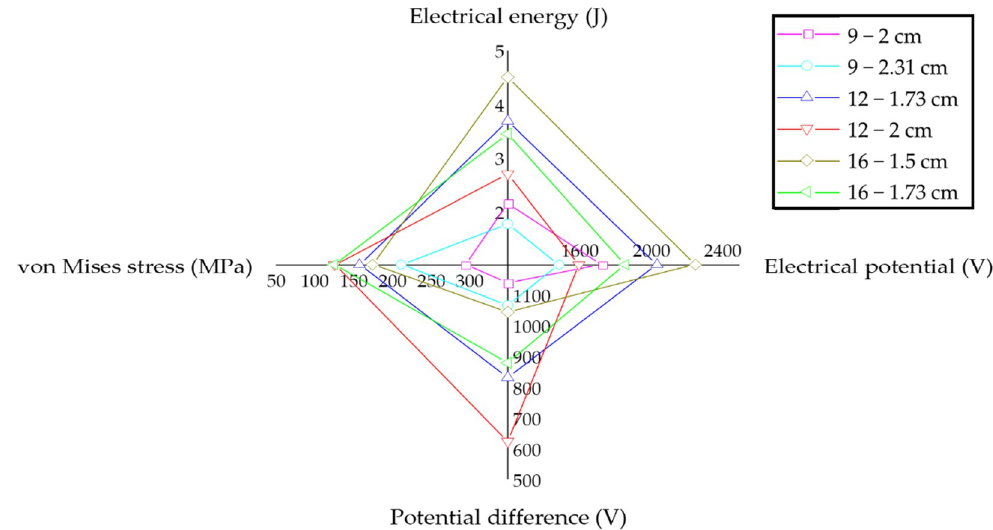
Figure 14. Radar chart of the output value of PEHs under full loading model.